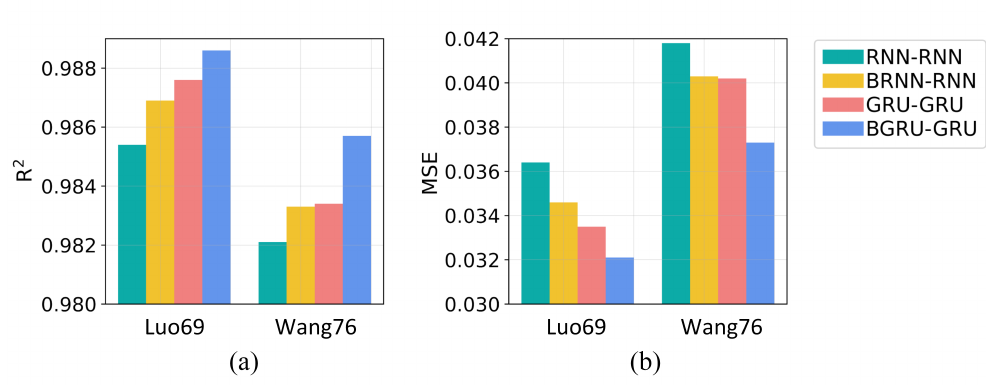
Figure 18. The Structure selection experimental results on ( a ) R 2 and ( b ) RMSE for TL-Seq2Seq. (4) Experiments on the number of hidden layer cells in TL-Seq2Seq The numbers of hidden layer units of the encoder and decoder in the TL-Seq2Seq are determined by experiments, whose results are shown in Figure 19. It can be seen that the results are best when the number of hidden layer units is set to 256 in the encoder and 128 in the decoder. Therefore, the numbers of hidden layer units for the encoder and decoder are set to 256 and 128 in this paper, respectively.